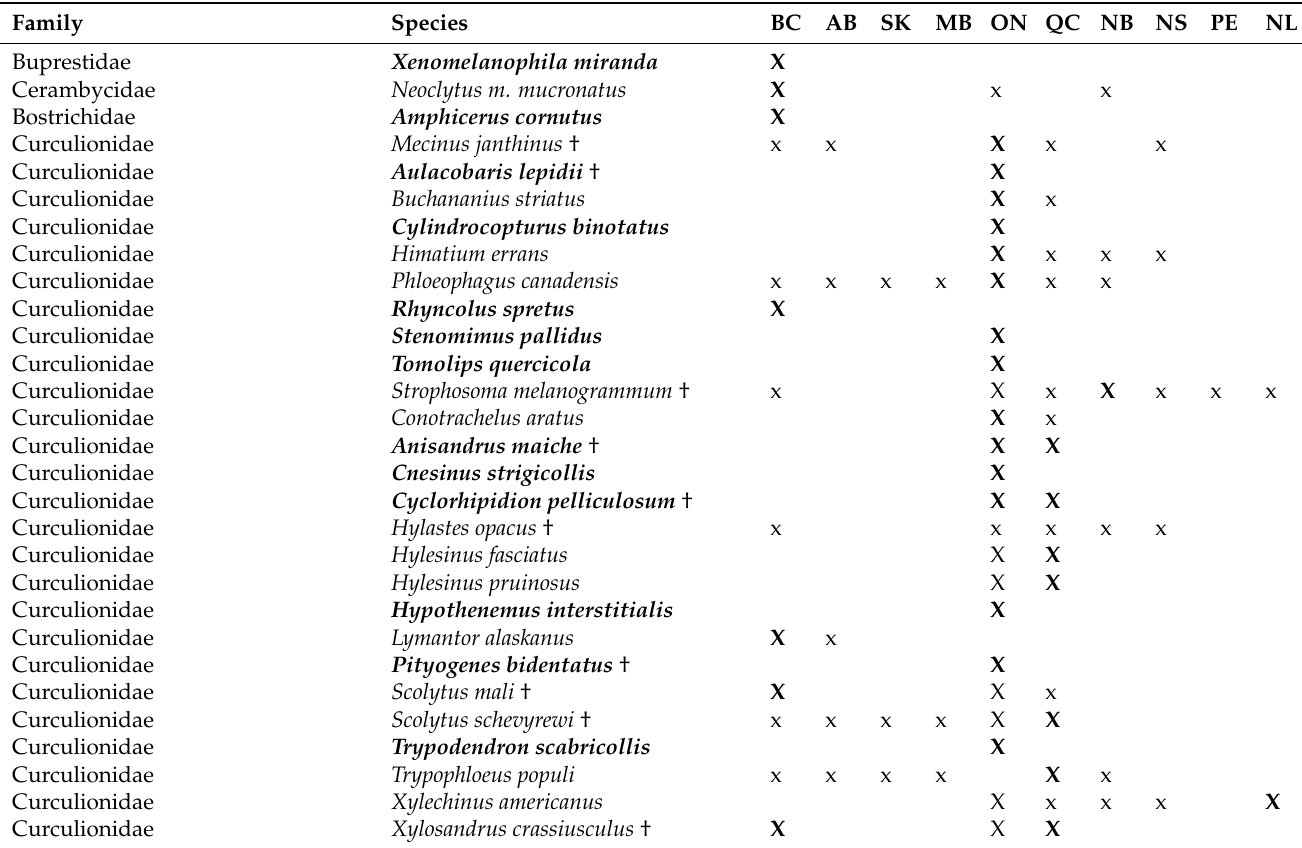
Table 2. Distribution in Canada, with new records highlighted ( X ). Species name in bold denotes a new Canadian record, and species with † are adventive to North America. None of the species have been recorded in Nunuvut, Yukon or Northwest Territory so these are not listed in the